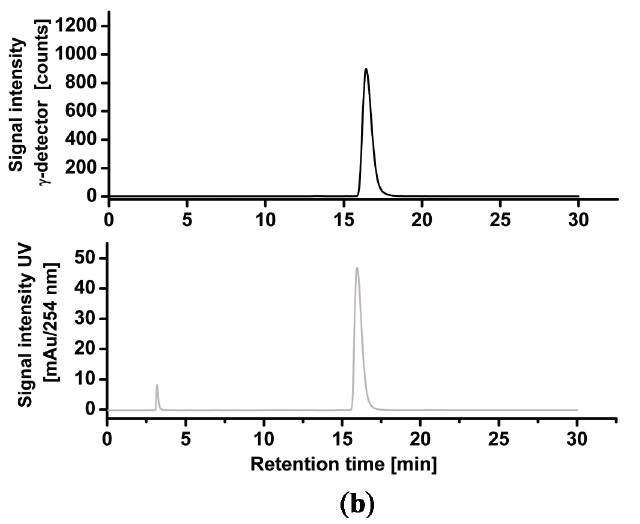
Figure 2. ( a ) Representative radio- and UV-chromatograms obtained for isolation of [ 18 F] 10a from crude reaction mixture by semi-preparative HPLC (Reprosil-Pur C18-AQ column, 35% MeCN/H 2 O/0.05% TFA, Flow rate: 10 mL · min − 1 ); (b ) Analytical radio-chromatogram (top) and UV-chromatogram (bottom) of purified [ 18 F] 10a spiked with the reference compound 10a